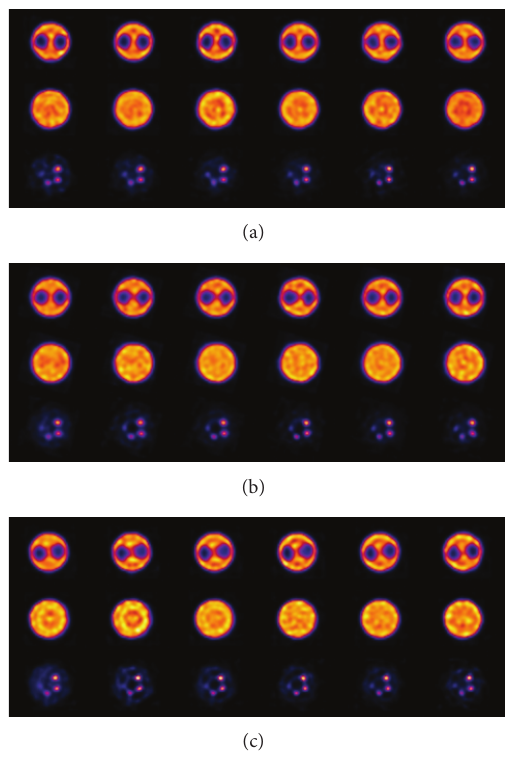
Figure 2: Reconstructed SPECT trans-axial slices of NEMA NU 4- 2008 filled with 99 m Tc-pertechnetate solution. Top images (a) have 𝑅 = 4.16 , middle images (b) have 𝑅 = 9.51 , and bottom images (c) have 𝑅 = 15.2 .